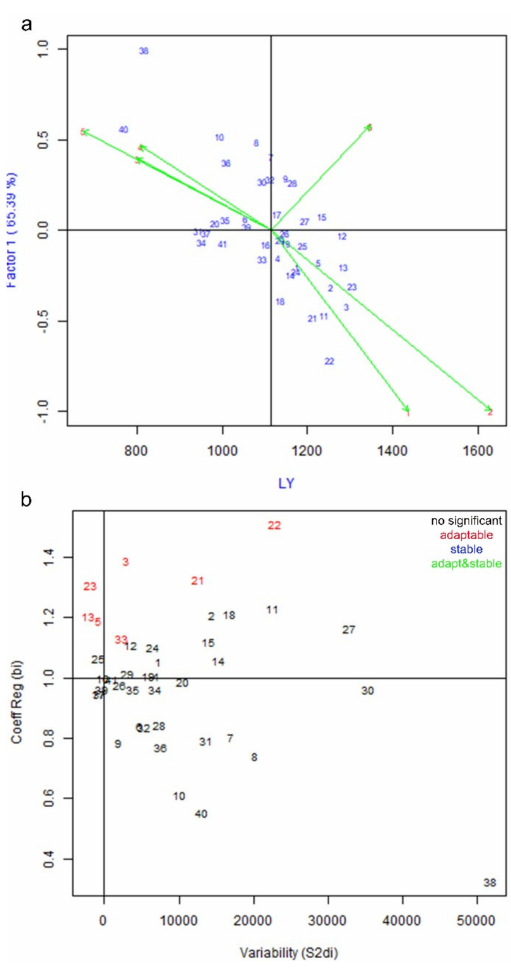
Figure 3. Mean performance and stability of 41genotypes at six environments for lint yield (LY). ( a ) Represents the mean of LY (kg / hec) on the X-axis and first interaction principal component (IPC1) scores of GEI on the Y-axis. Blue and red colored numbers inside the biplot show genotypes and environments, respectively. ( b ) Shows stability analysis of LY, coe ffi cient of variability (X-axis) and coe ffi cient of regression (Y-axis). All numbers inside the biplot show genotypes. See Tables 1 and 2 for code description of genotypes and environments,